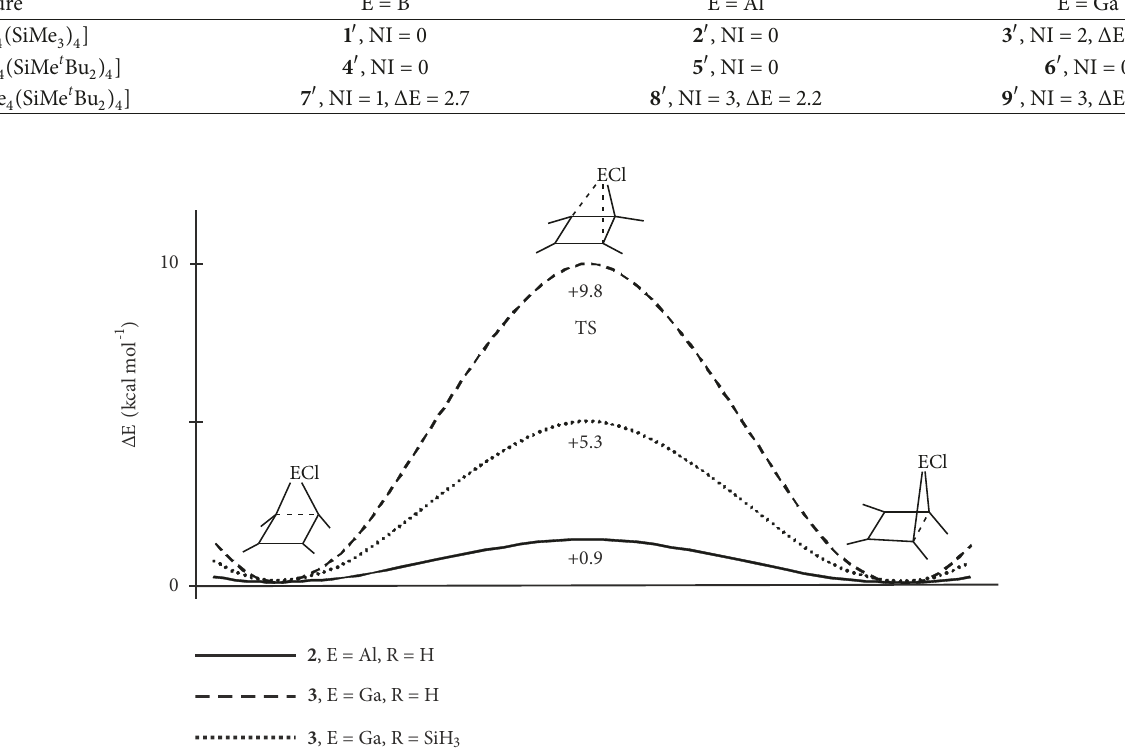
Figure 2: Energy profile for migration of ECl-fragment around the C 4 R 4 basal ring for systems 2 and 3 .